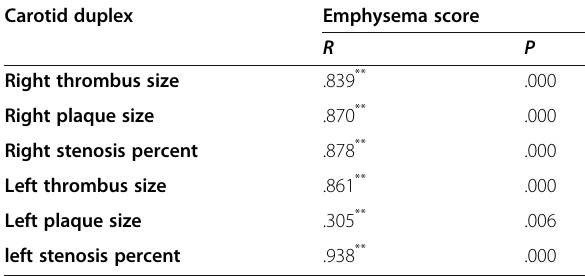
Table 2 Correlation between emphysema score and carotid duplex Carotid duplex Emphysema score